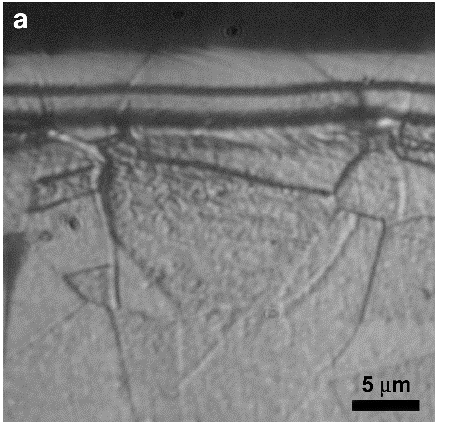
Figure 5. X-ray diffraction patterns of AISI 316L samples: ( a ) untreated; ( b ) plasma nitrided at 380 °C, 340 Pa, 3 h (Bragg-Brentano configuration, Cu K α radiation). For further experimental details, see [70]. Even if the formed modified layers are fairly homogeneous, grain-to-grain variation in thickness may be observed, owing to different N diffusion in differently oriented grains [104,124], as also pointed out by Abrasonis et al. [124] when studying ion beam nitriding of single crystals. Etching also allows to outline the grain boundaries, which appear as the continuation of the austenite matrix grain boundaries, and the continuation of the characteristics twins present in the matrix has been observed [116]. Both grain boundaries and twins may show a slight rotation with respect to the substrate, in accordance with the analysis of the surface (see Section 4.1.) [126]. In the outer modified layer many lines can be observed. Their number and extension in the substrate depend on nitriding condition and alloy composition [70,71]. These lines are well observable in tapered section, where the complex structure of slip lines and shear bands (here intended as a collective term for planar defects that form during plastic deformation as a result of the overlapping of stacking faults on austenite {111} planes [71,136]) due to the plastic deformation of the outer part of the modified layer is easily recognizable [71]. In the X-ray diffraction analysis of the nitrided layers, beyond the peaks of the S phase, the presence of additional peaks has been reported [57,68,70,71,137]. These peaks have been ascribed to a solid solution of N in hexagonal close-packed